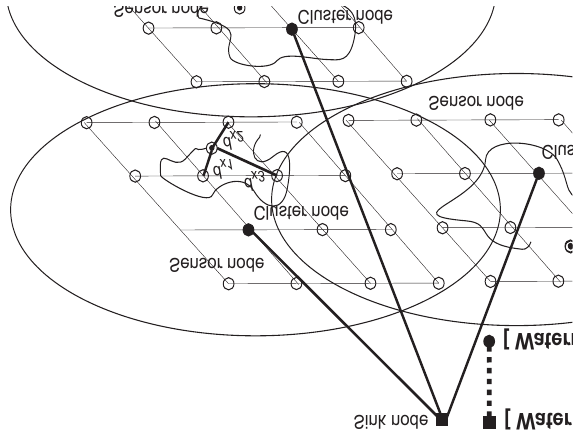
Figure 3. Illustration of a watermarking